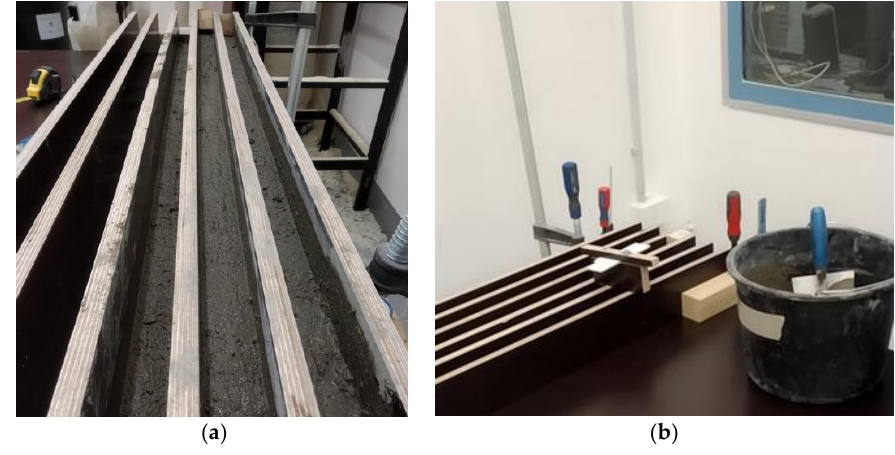
Figure 7. Forming process. ( a ) Forms with deposited concrete, ( b ) Forms with adjustable trowel.